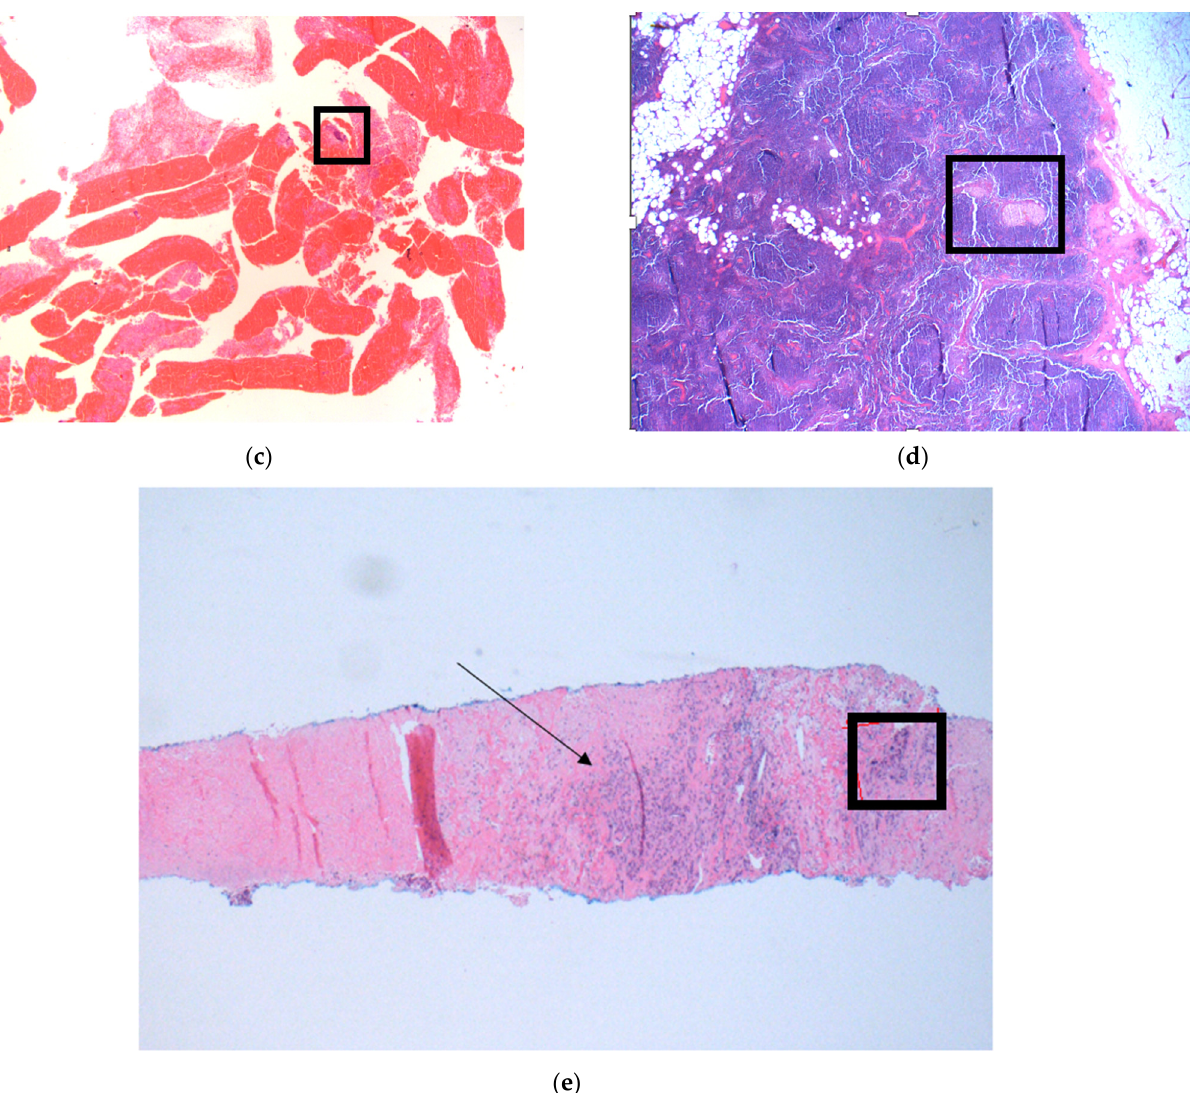
Figure 1. Photomicrographic examples of histopathological tissue biopsies containing scarce or no malignant tissue. ( a ) Photomicrograph of bronchial biopsy (×4 magnification) showing the limited nature of some samples. This is small-cell neuroendocrine carcinoma (haematoxylin and eosin (H&E) stain). ( b ) Some CT-guided core biopsies may not contain malignancy but rather necrotic material, as in this example (×4, H&E). ( c ) Endobronchial ultrasound-guided (EBUS) fine needle aspiration cytology of mediastinal lymph nodes. EBUS samples often yield small amounts of tissue on a background of blood. A small fragment of carcinoma is highlighted in the black square (×4, H&E). ( d ) Photomicrograph illustrating a small deposit of metastatic carcinoma (black square) in a lymph node. Bulk RNA extraction from this section, without microdissection, is likely to yield large amounts of wild-type signal from lymphocyte nuclei. ( e ) An example of low-volume malignancy with a CT-guided core biopsy of lung highlighted in the black square. There is fibrosis and chronic inflammation (arrow) present in the background (×4, H&E).